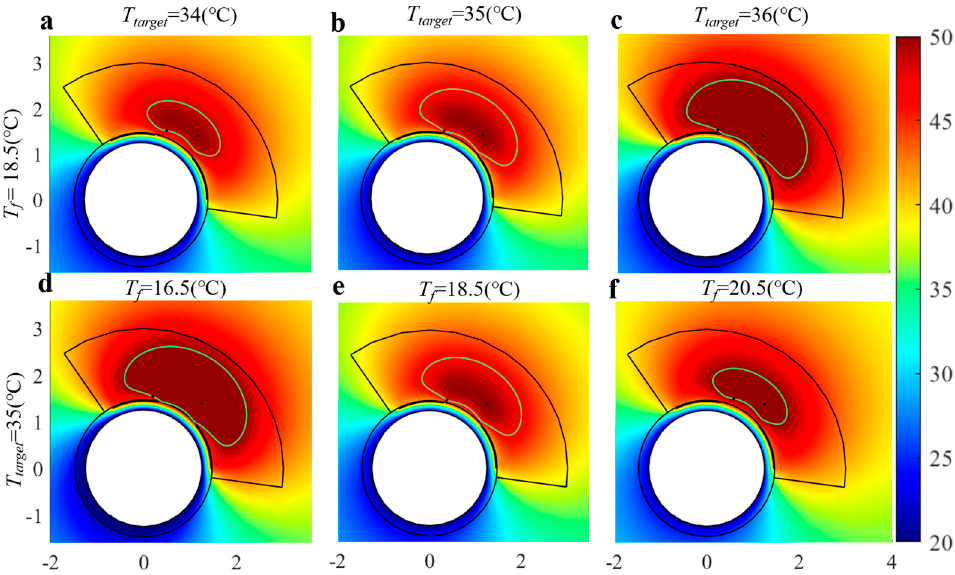
Figure 7. The ablation zone (marked with a green line) varied as T target ( a – c ) or T f ( d – f ) increased. V f = 2m/s in all conditions. V f = 2 m/s in all